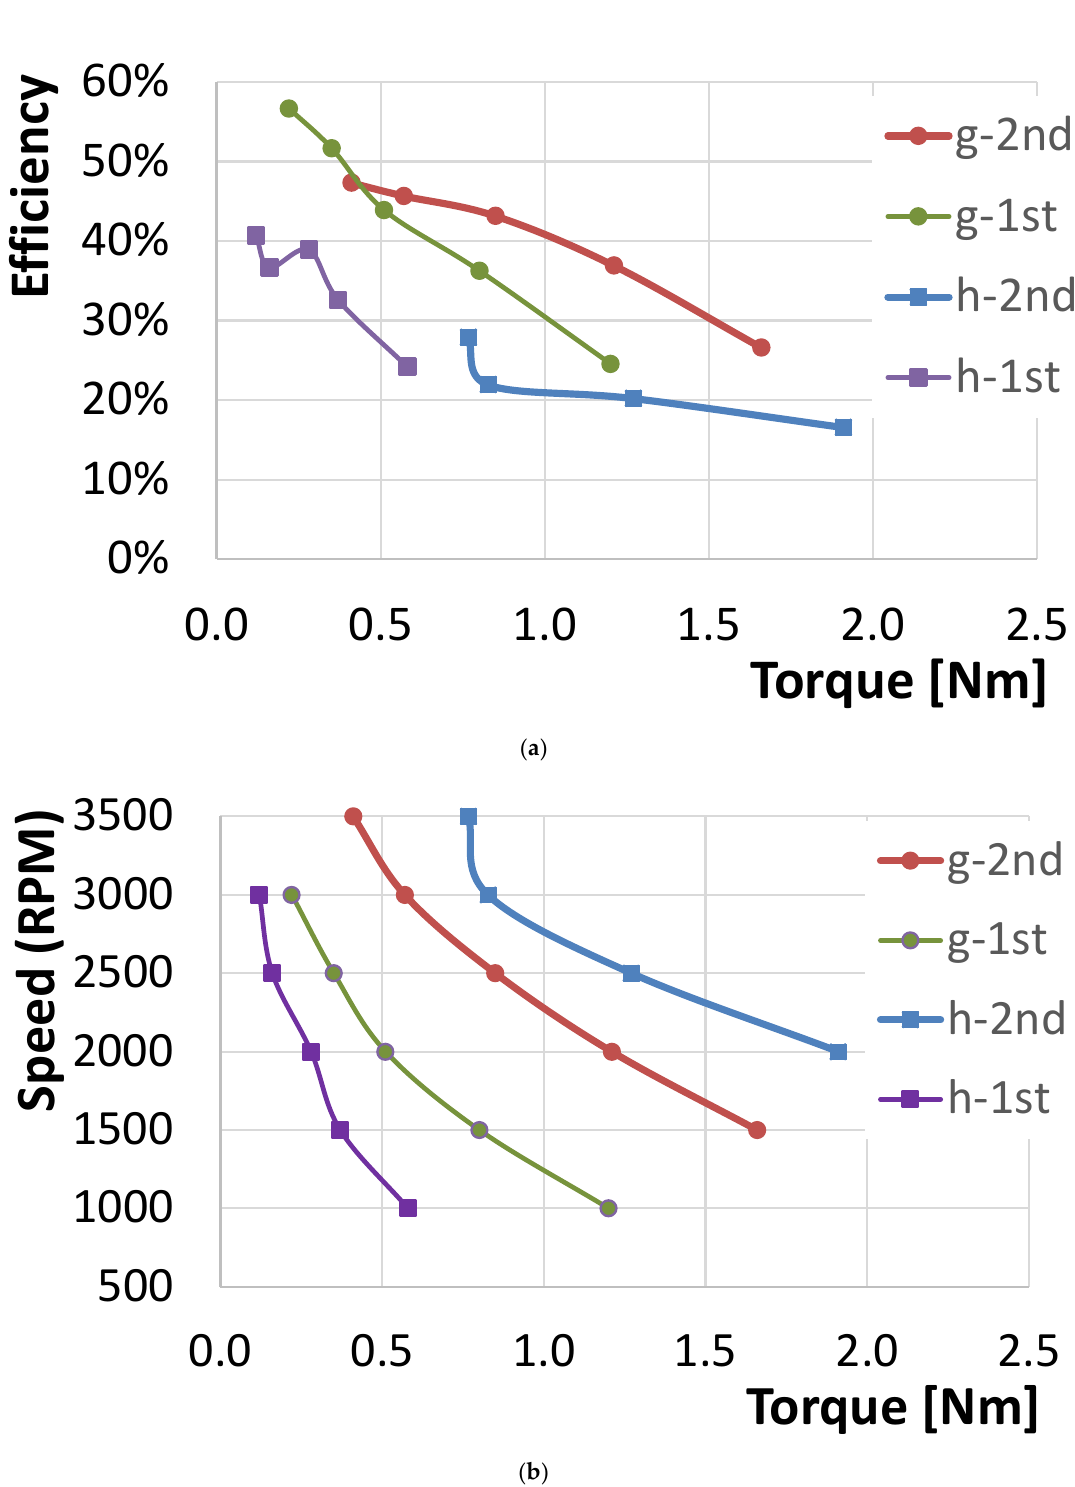
Figure 13. Efficiency ( a ) and speed ( b ) vs. torque dependencies of g- and h-winding interconnections, experiments with the Li-Pol battery (1st round), and with the lead-acid battery (2nd round).